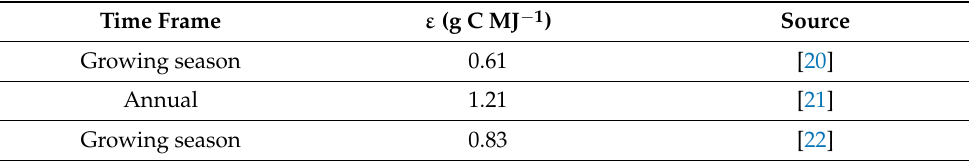
Table 2. Literature-based LUE parameter values for